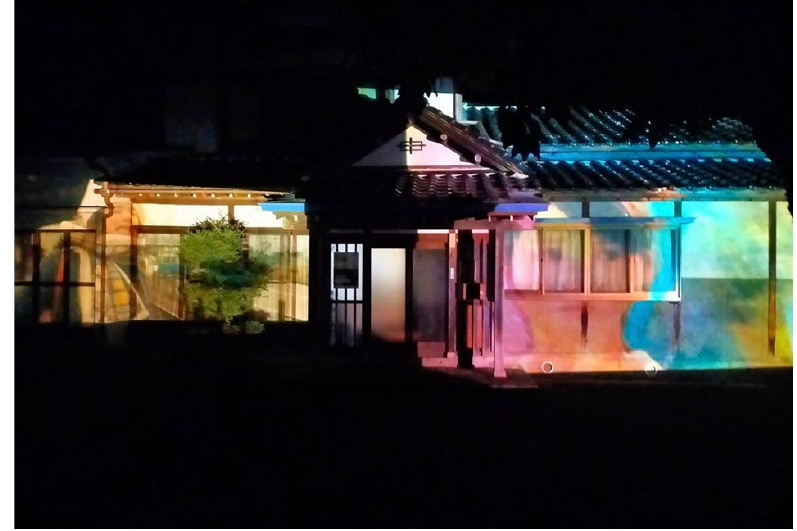
Figure 34 Projection event in the workshop “For the Sake of Anyone Whom We Might Not Have Seen